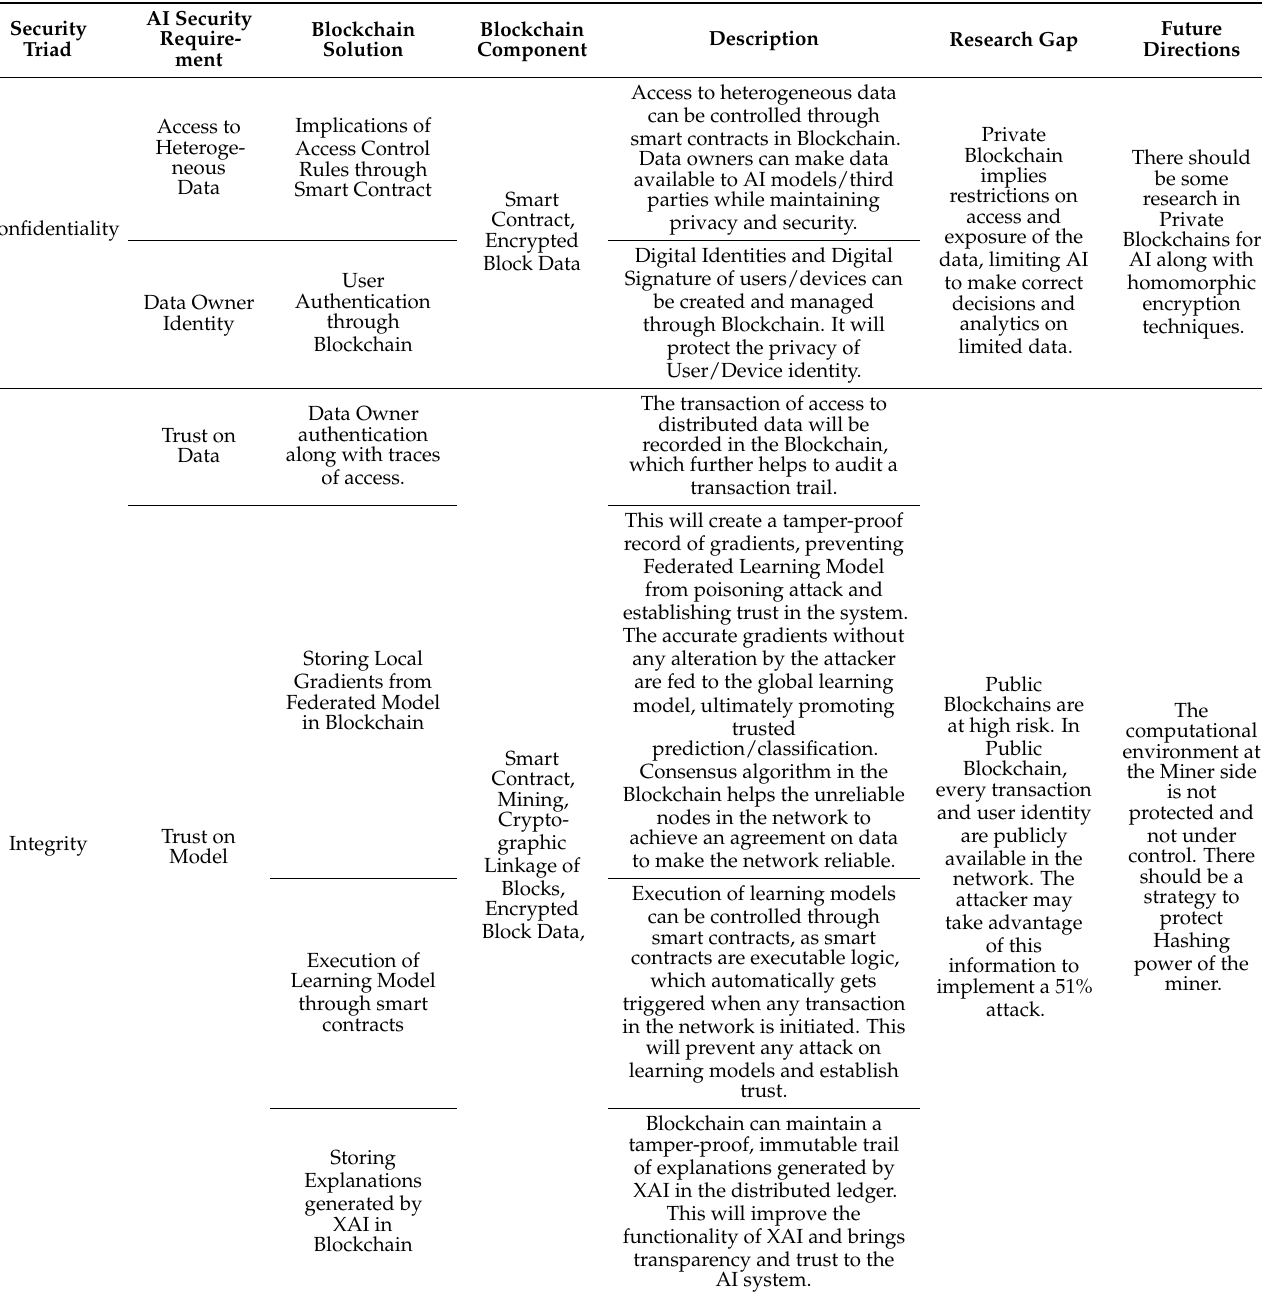
Table 21. Research Gap and Future Research Directions in Blockchain for